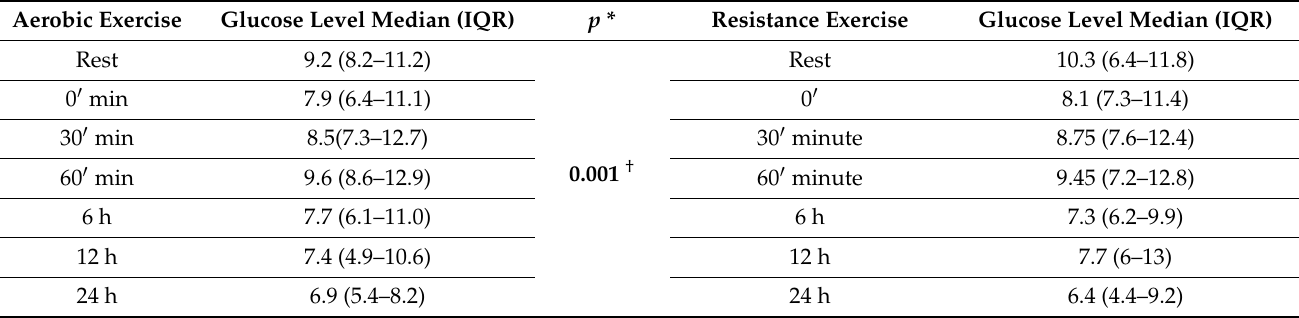
Table 2. Differences in glucose levels at different time points during aerobic and resistance training sessions; data from